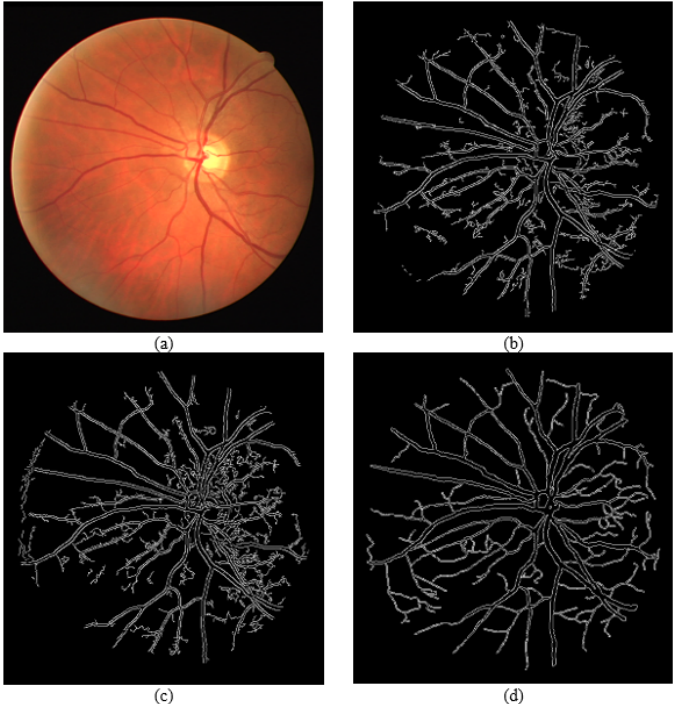
Figure 16. Comparison of segmented images for Photo 2 . ( a ) Input image. ( b ) Segmented image using the proposed approach (GUI based). ( c ) Segmented image using Canny detector with ideal parameters. ( d ) Ground truth image from DRIVE